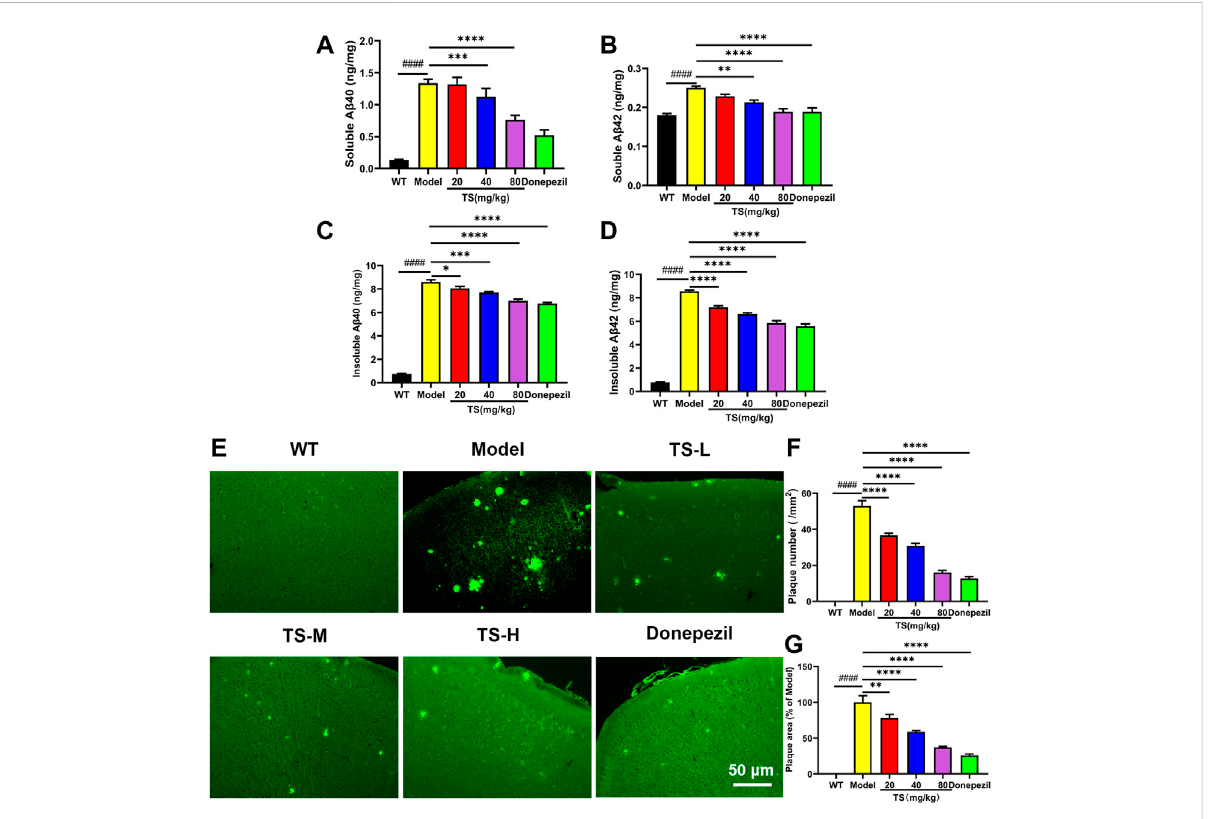
FIGURE 3 TS treatment decreased the levels of A β and senile plaque in the brain of APP/PS1 mice. (A) The effect of TS on the levels of soluble A β 40 in the brainofAPP/PS1micewasmeasuredbyELISA( #### p < 0.0001,*** p =0.0003,**** p < 0.0001). (B) TheeffectofTSonthelevelsofsolubleA β 42inthe brain of APP/PS1 mice was measured by ELISA ( #### p < 0.0001, ** p = 0.0015, **** p < 0.0001). (C) The effect of TS on the levels of insoluble A β 40 in the brain of APP/PS1 mice was measured by ELISA ( #### p < 0.0001, * p = 0.0220, *** p = 0.0002, **** p < 0.0001). (D) The effect of TS on the levelsofinsolubleA β 42inthebrainofAPP/PS1micewasmeasuredbyELISA( #### p < 0.0001,**** p < 0.0001). (E) TheeffectofTSonthesenileplaque in the brain of APP/PS1 mice was investigated by ThS fl uorescence. (F) Quantitative analysis of the number of senile plaques in the brain of